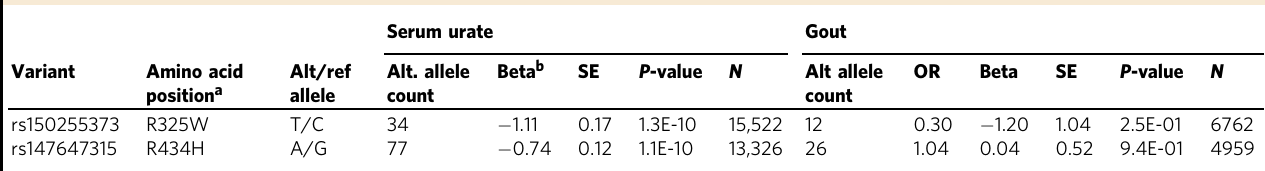
Table 1 Novel rare missense variants in SLC22A12 associated with serum urate in the primary single-variant meta-analysis combining EA and AA